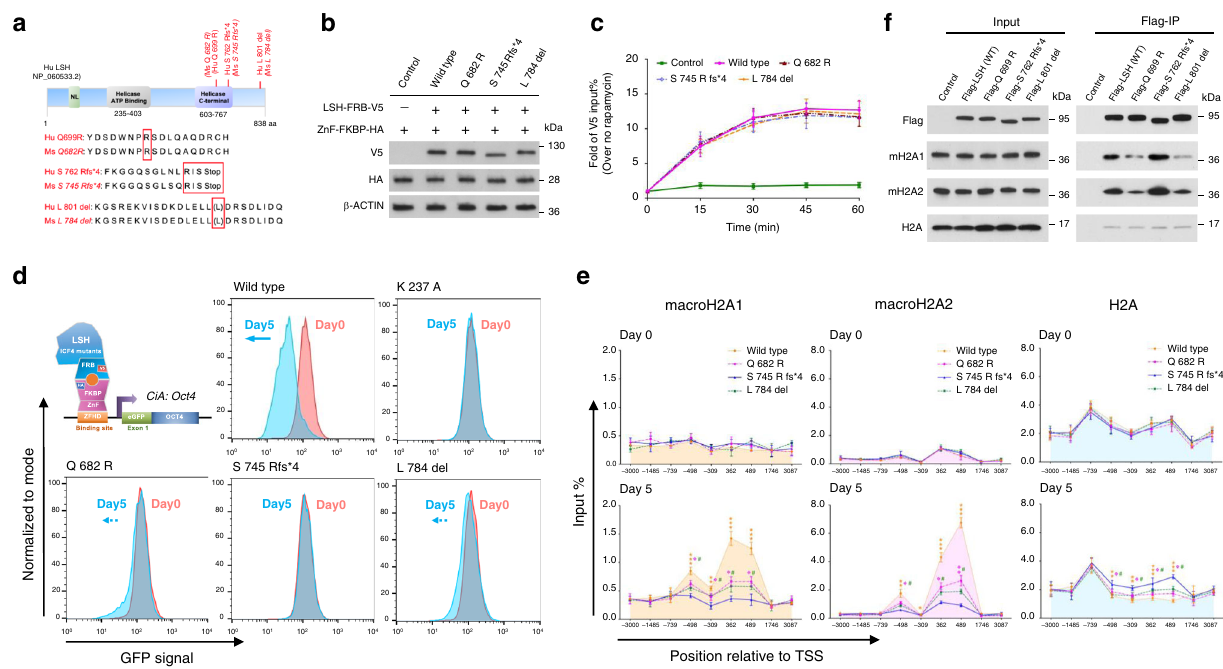
Fig. 6 ICF4 derived LSH mutations fail to induce transcriptional repression and macroH2A deposition. a Schematic representation of ICF4 associated human LSH mutations (red box) and alignment with murine LSH. b Western blot analysis to con fi rm the expression of three LSH-FRB-V5 mutant proteins and ZnF-FKBP-HA protein in ICF4 associated LSH CIP system compared to that in wild-type LSH CIP system using V5 and HA antibodies. Cells lacking LSH-FRB-V5 fusion protein expression served as controls. c ChIP-qPCR analysis to determine the recruitment of ICF4 associated LSH mutants and wild- type LSH to the engineered Oct4 locus in the CIP system after rapamycin treatment at indicated time points using V5 antibody ( n = 3 independent experiments). Cells lacking LSH fusion protein expression served as controls. Data are represented as mean ± SD. d Flow cytometry was used to measure reporter-GFP expression in ICF4 derived LSH mutants CIP system compared to that in wild-type or ATP mutant LSH (K 237 A) CIP system after 0 (red) and 5 (blue) days treatment of rapamycin. e ChIP-qPCR analysis to assess the dynamic changes of macroH2A1, macroH2A2 and H2A enrichment at the CiA: Oct4 locus in the engineered mouse ES cells tethered with ICF4 associated LSH mutants or wild-type LSH with rapamycin treatment for 0 and 5 days ( n = 3 independent experiments). Data are represented as mean ± SD. Signi fi cance assessed using one-way ANOVA with Tukey ’ s multiple comparison test (wild type: *adjusted p < 0.05, ** adjusted p < 0.01 and ***adjusted p < 0.001; Q 682 R: ❖ adjusted p < 0.05 and ❖❖ adjusted p < 0.01; L 784 del: # adjusted p < 0.05). f Flag-IP of indicated proteins con fi rmed by western blot analysis in U2OS cells with a stable expression of wild-type Flag-LSH or ICF4 associated Flag-LSH mutants. Cells without a stably integrated of Flag-LSH expression vector served as controls. Source data are provided as a Source Data fi